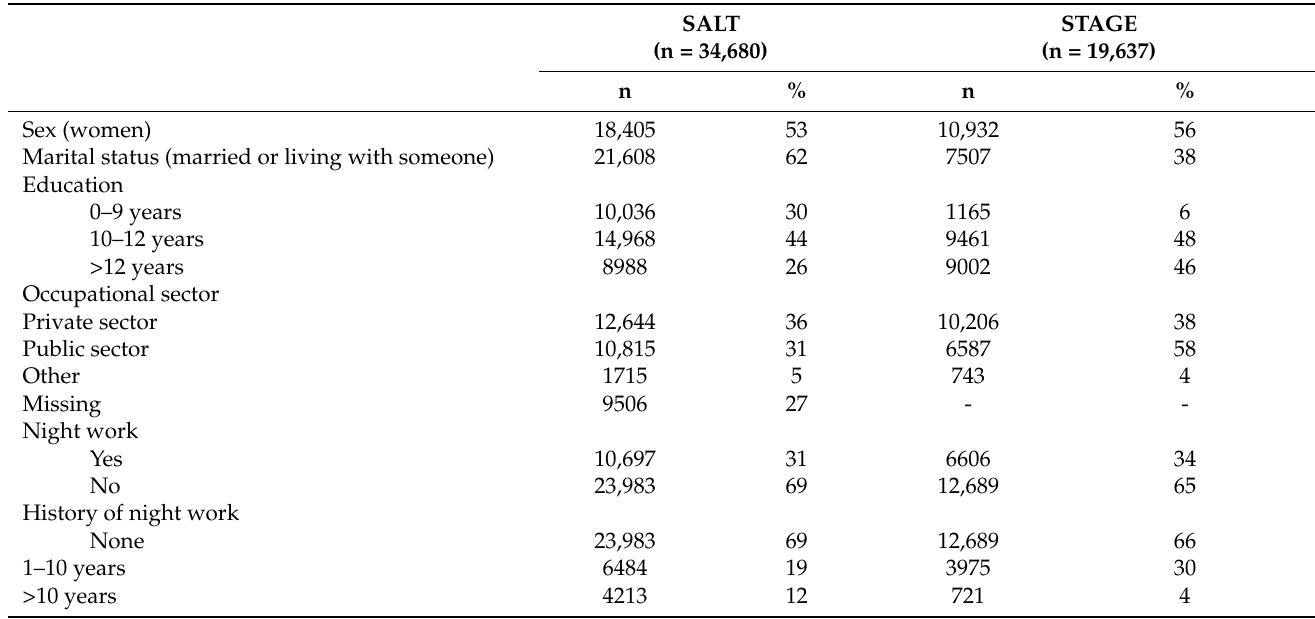
Table 1. Descriptive characteristics of the SALT and STAGE cohorts in this study. SALT (n = 34,680)